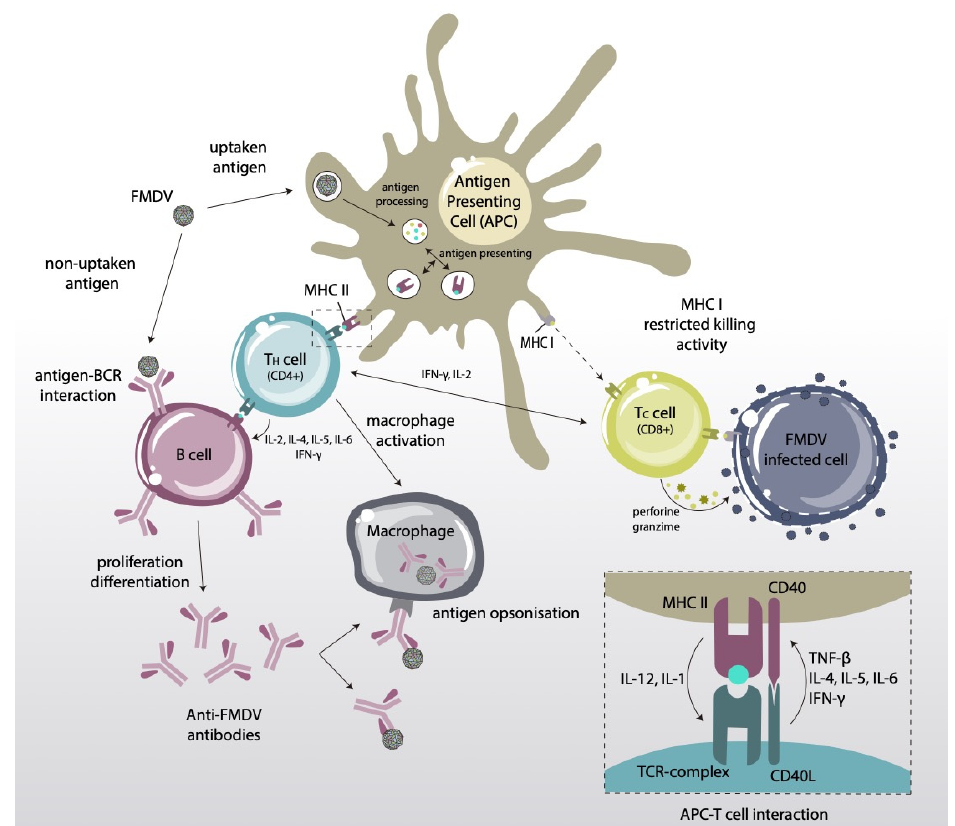
Figure 3. Schematic representation of the adaptive immune response induced by FMDV. APCs present viral peptides (T-cell epitopes) via MHC class I and II molecules to CD8+ and CD4+ T-lymphocytes, respectively. CD4+ T-cells can (i) cooperate with activated B-lymphocytes to produce nAbs; and (ii) interact with CD8+ T-lymphocytes that are previously activated by association with MHC class I molecules on the surface of infected cells, to trigger a cytotoxic (CTL) response.